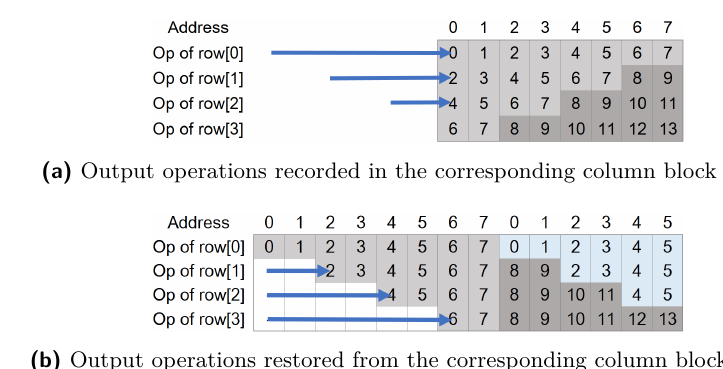
Figure 12: Management for the operation and data memory for n − k = 8 and s = 4.